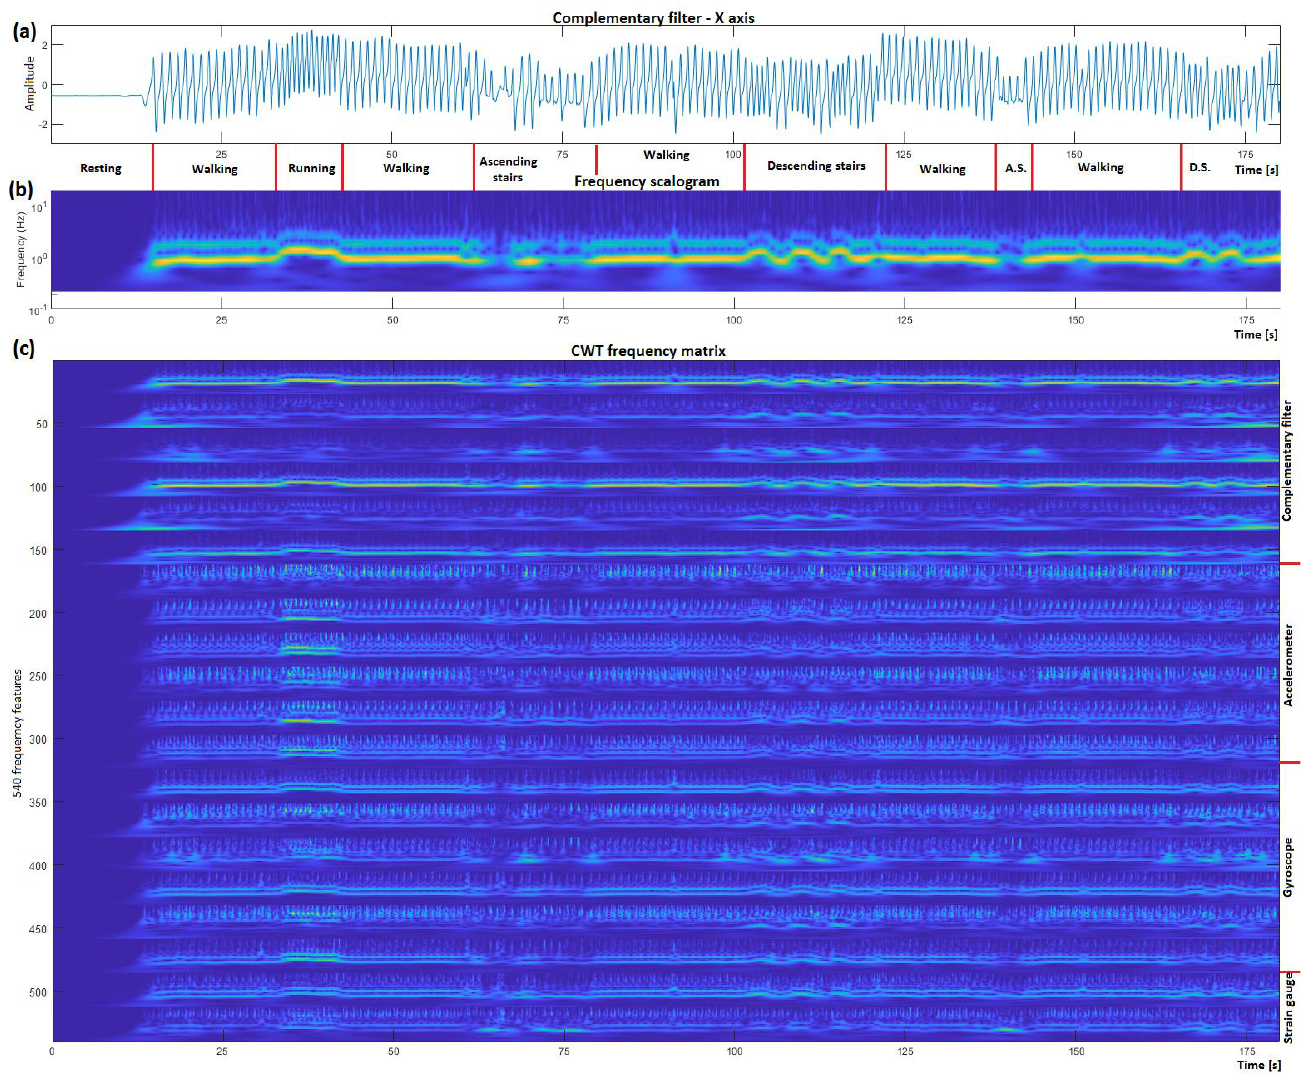
Figure 6. CWT time to frequency domain transformation visualized. ( a ) Presents the normalized X axis of the complementary filter; ( b ) visualizes the result from the CWT algorithm; ( c ) presents the stacked CWT result of each sensor signal.